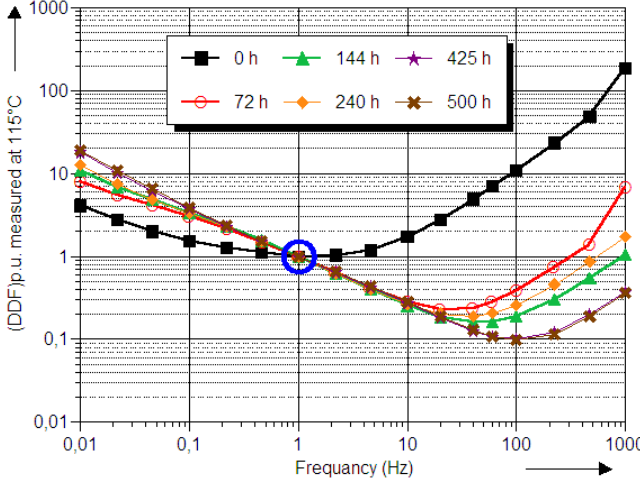
Figure 12. The per unit values of the DDF as a function of aging duration.